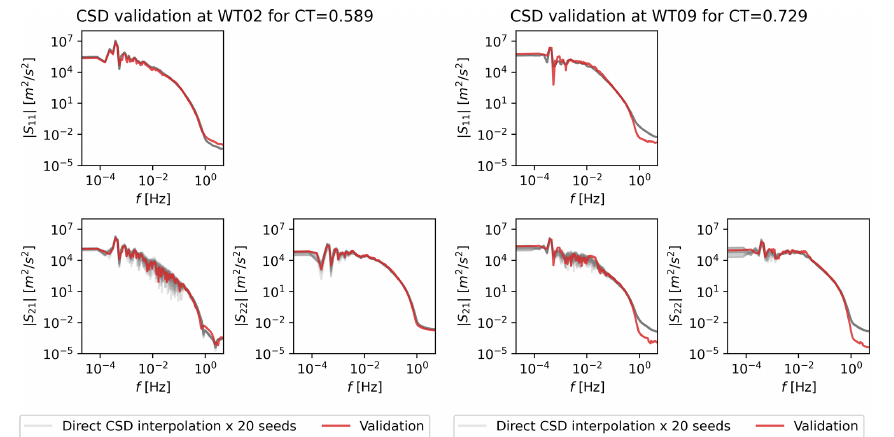
Figure 12. CSDs of 20 realizations of the PS-ROM using direct interpolation compared to the validation CSD for WT02 and WT09.